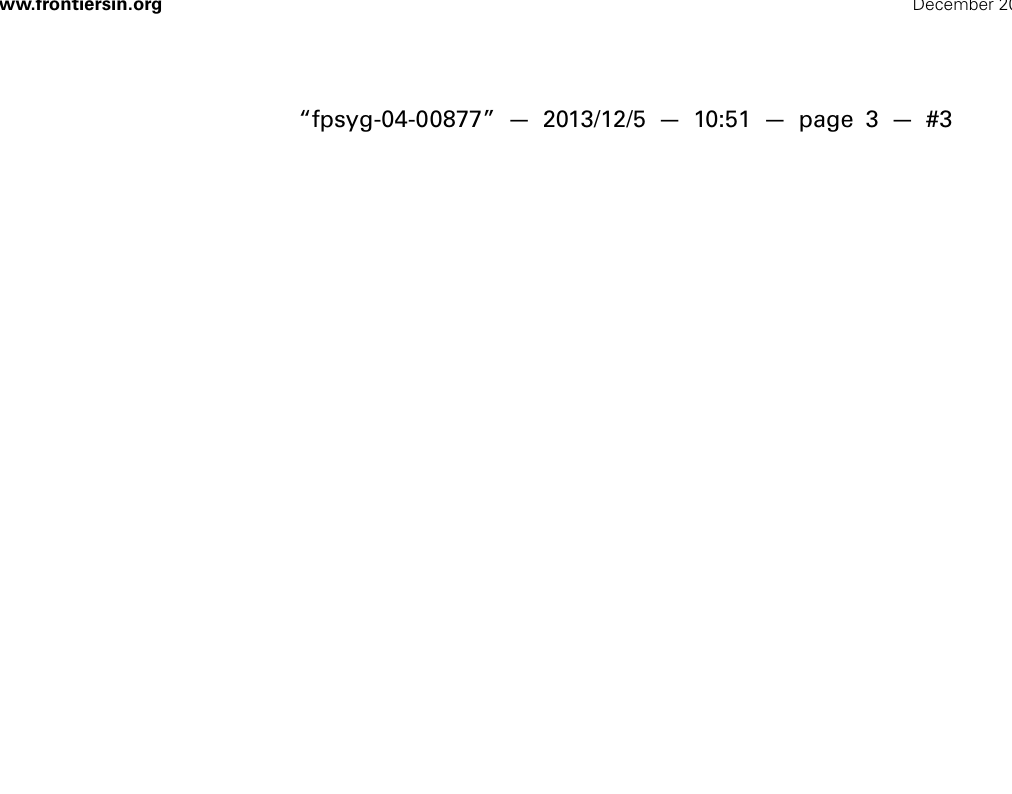
FIGURE 1 | Illustration of redeployment view of the relation between finger and number representations.